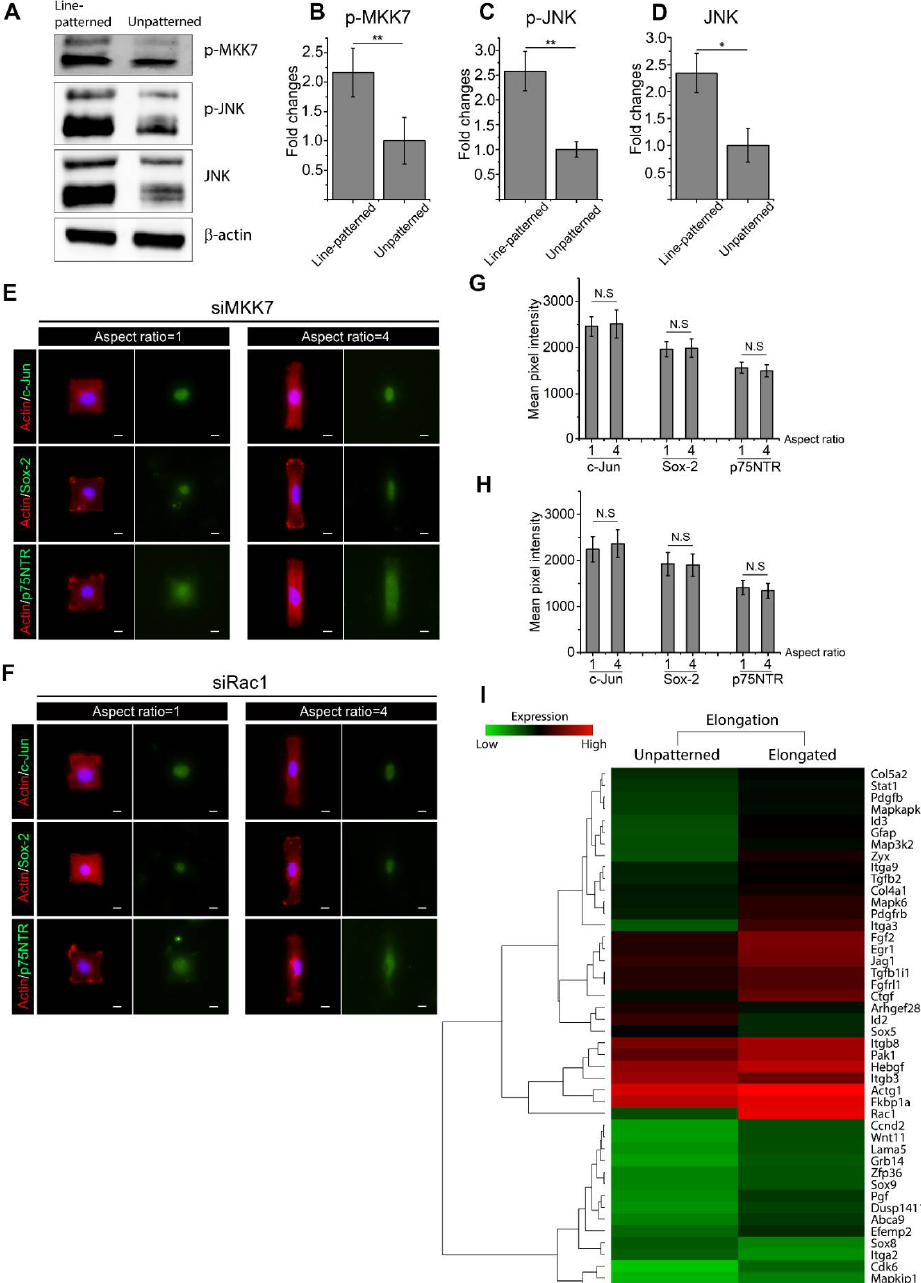
Figure 5. Schwann cell (SC) elongation promotes a regenerative phenotype via the Rac1/MKK7/JNK signal cascade. ( A – D ) Rac1/MKK7/JNK signaling is activated when SCs are seeded on line-patterned substrates compared to unpatterned surface. Two cell lysates were created for Western blot quantification. ( E , F ) SCs were transfected with MKK7 and Rac1 siRNA and subsequently seeded on micropatterned cell adhesive islands where cell spreading area was maintained at 1600 µ m 2 but with different extents of elongation. Immunofluorescence staining was performed to stain F-actin (red), nucleus (blue), c-Jun (green), Sox-2 (green) and p75NTR (green). Mean pixel intensities of c-Jun, Sox-2 and p75NTR were measured to quantify SC regenerative capacity. For fluorescent intensity quantification of micropatterned SCs, 4 unique trials with a minimum of 30 single micropatterned SCs per trial were quantified. Scale bar = 10 µ m. ( G , H ) Statistical analysis shows that cell elongation is not able to promote SC regenerative phenotypes after Rac1/MKK7/JNK signaling inhibition. ( I ) Microarray analysis shows activation of Rac1-associated signaling and SC regenerative markers within elongated cells. Data are presented as the mean ± SEM. * p < 0.05, ** p < 0.005, p -values found in Supplemental Table